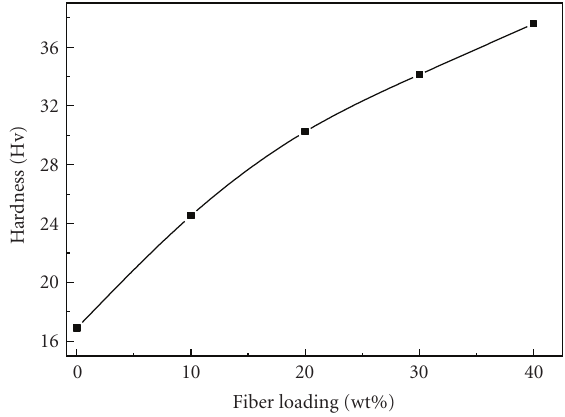
Figure 3: E ff ect of fiber loading on hardness of